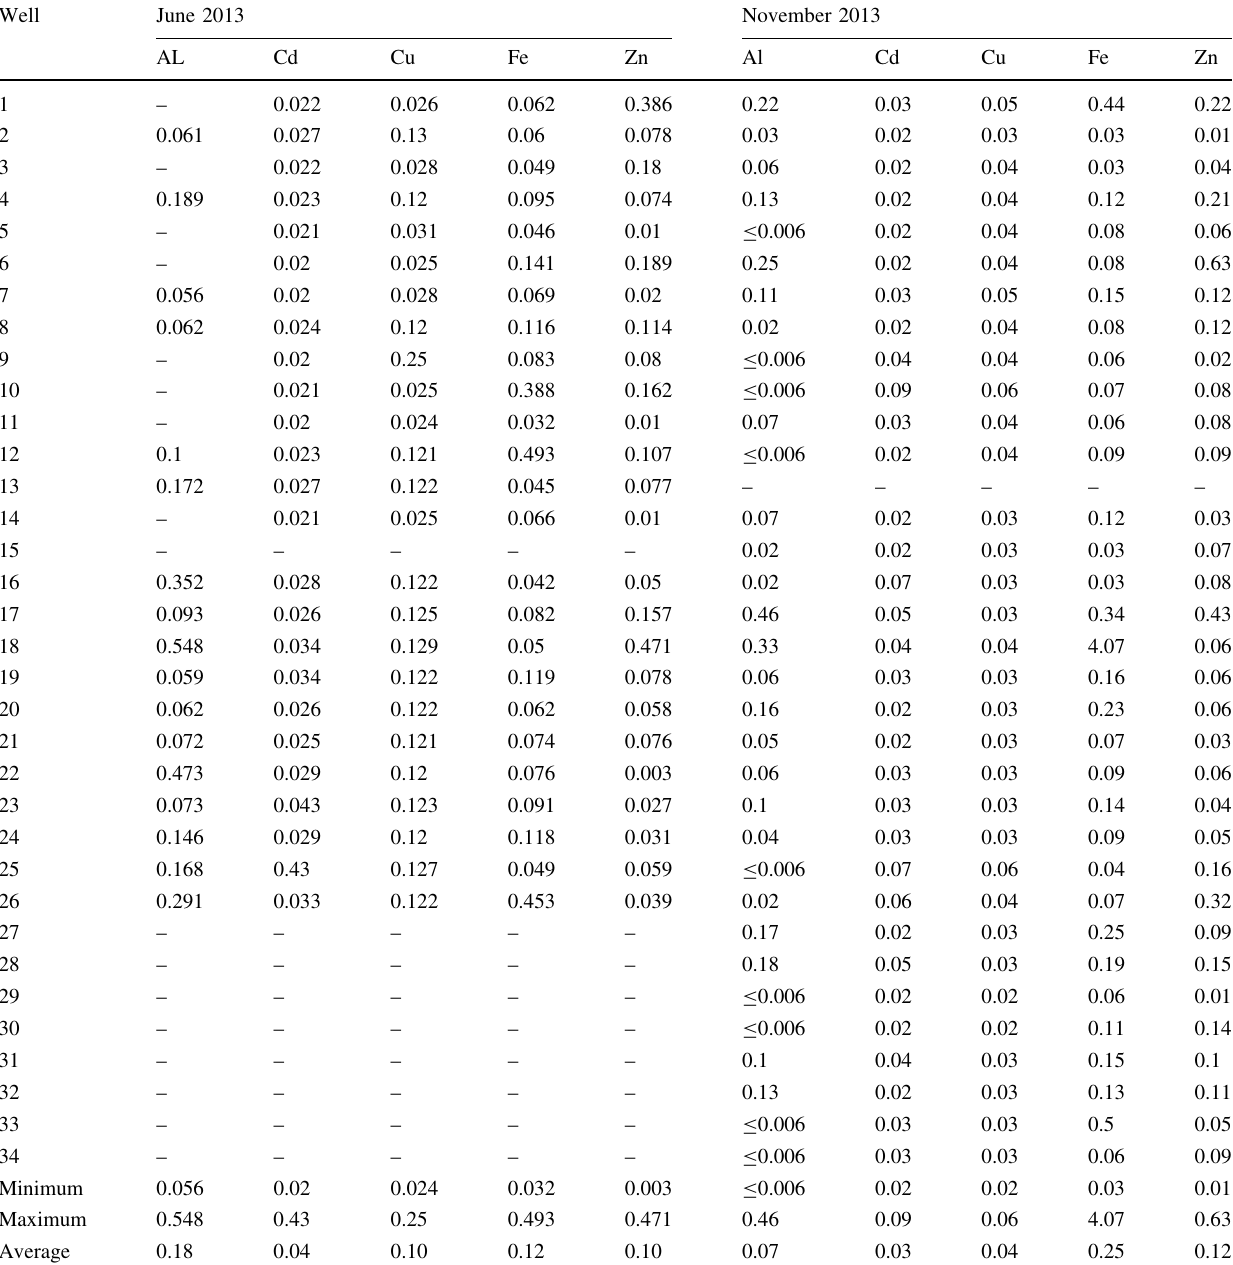
Table 4 Metal concentrations of groundwater sampled in the wells in June 2013 and November 2013 (mg/l)